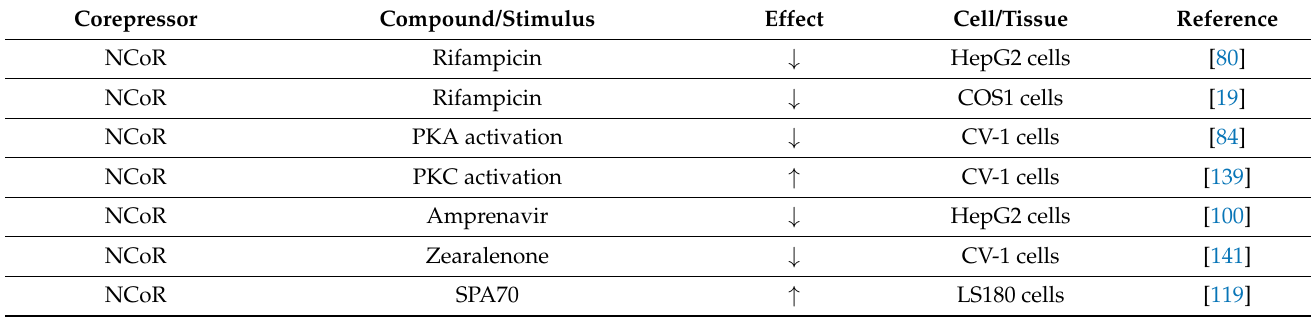
Table 2. Factors modifying the interaction